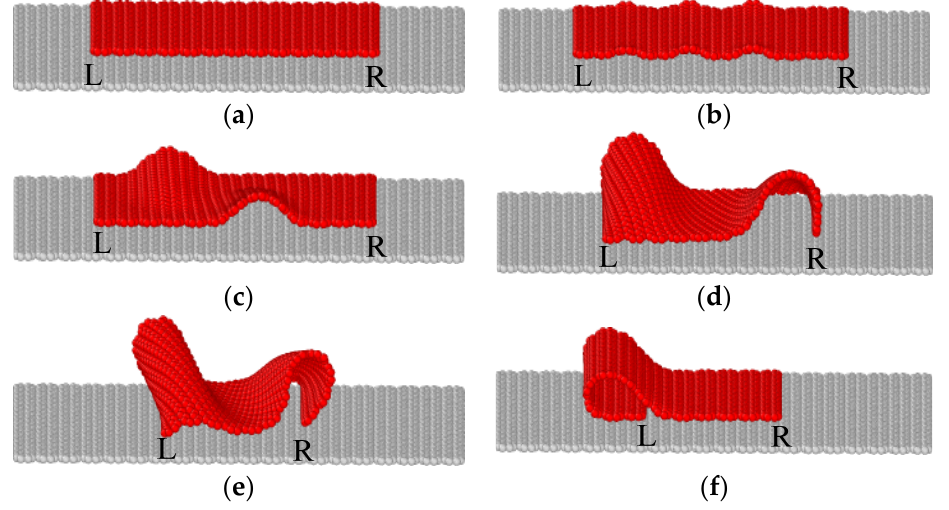
Figure 3. Configurations of the graphene sheet at points A–F of the curve in Figure 2. ( a ) Δ u x / l = 1.37%; ( b ) Δ u x / l = 2.00%; ( c ) Δ u x / l = 3.71%; ( d ) Δ u x / l = 24.09%; ( e ) Δ u x / l = 50.89%; ( f ) Δ u x / l = 50.93%.